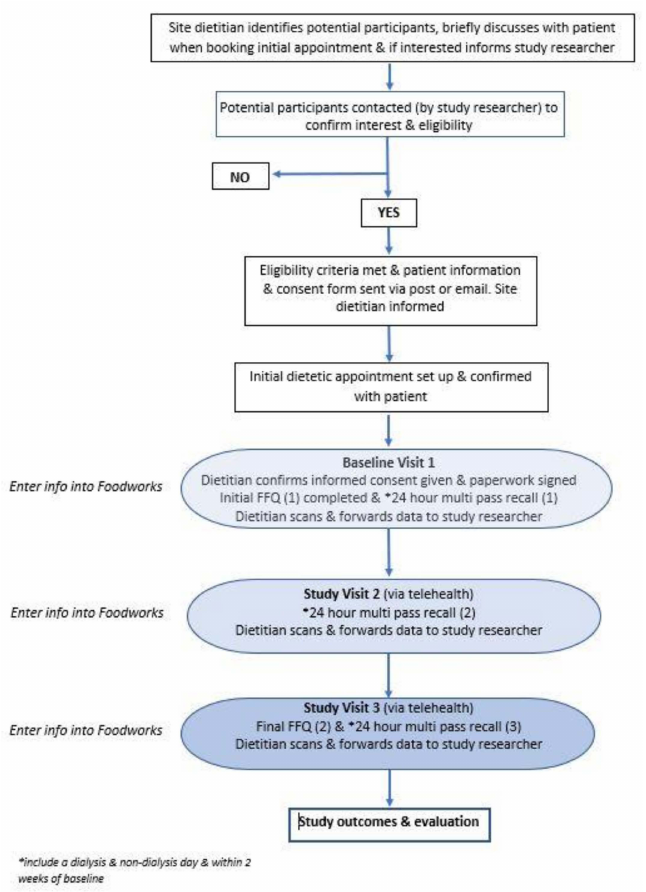
Figure 1. ViP kidney study plan